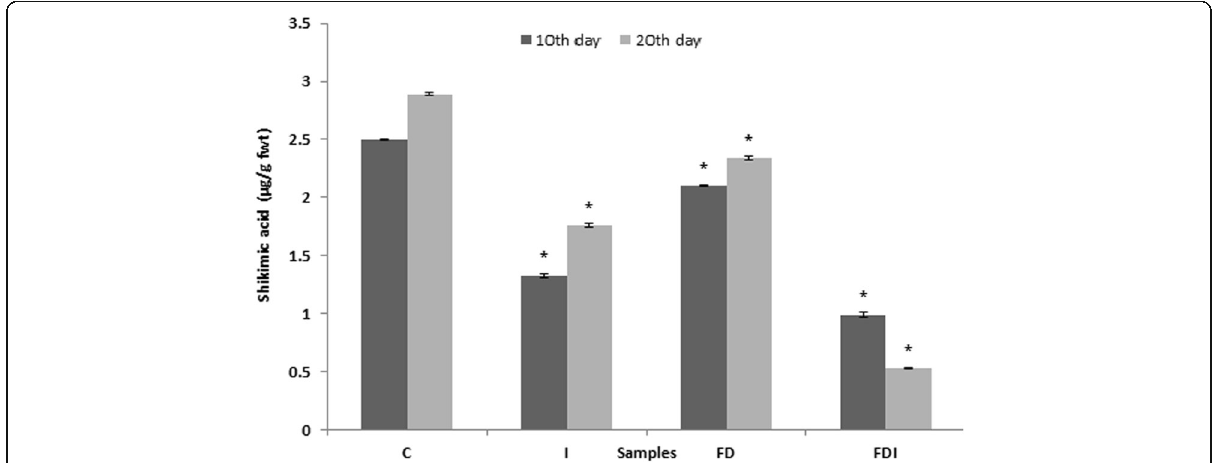
Fig. 5 Effect of defensin priming on Shikimic acid content in plants under Fusarium infection. C: Control plants (plants grown from non-primed grains in non-infected soil, FD: plants grown from defensin primed grains in non-infected soil, I: plants grown from non-primed grains in Fusarium infected soil and FDI: plants grown from defensin primed grains in Fusarium infected soil. The columns followed by asterisks are significantly different from the control according to paired-samples t test. The bars represent the standard error. Values are means of three replicates